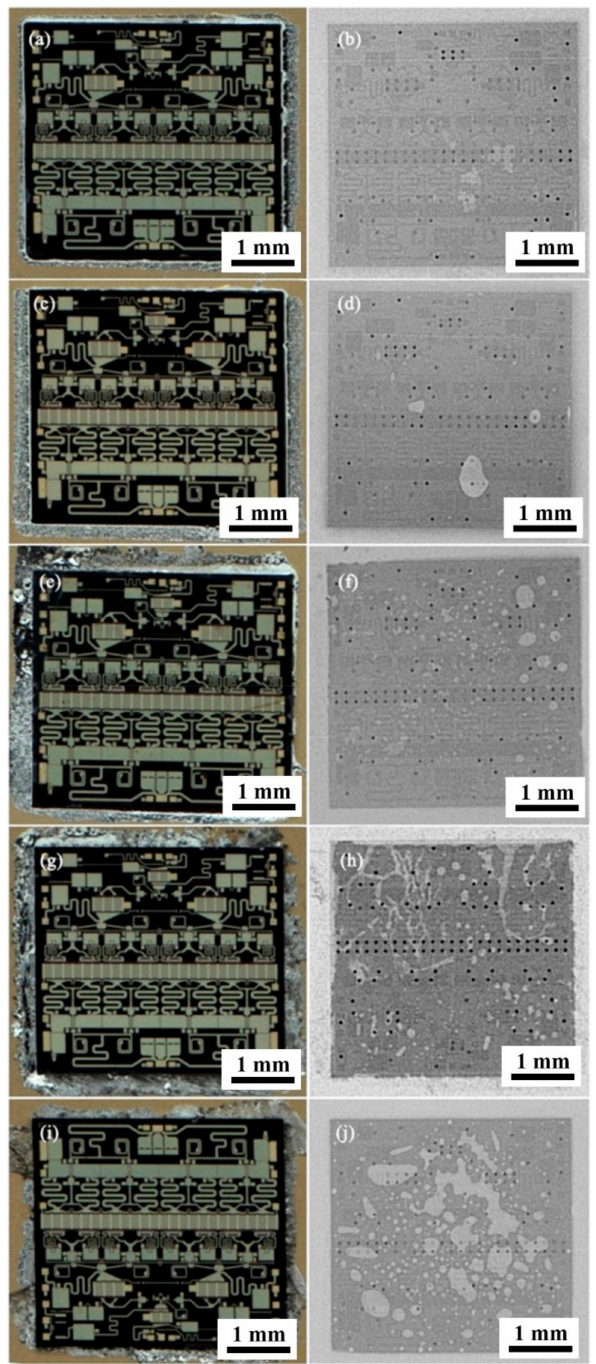
Figure 6. Appearances and X-ray inspection images of chips packaged using Au-20Sn solders with the oxygen content of: ( a , b ) 18 ppm; ( c , d ) 27 ppm;( e , f ) 40 ppm; ( g , h ) 53 ppm; ( i , j ) 77